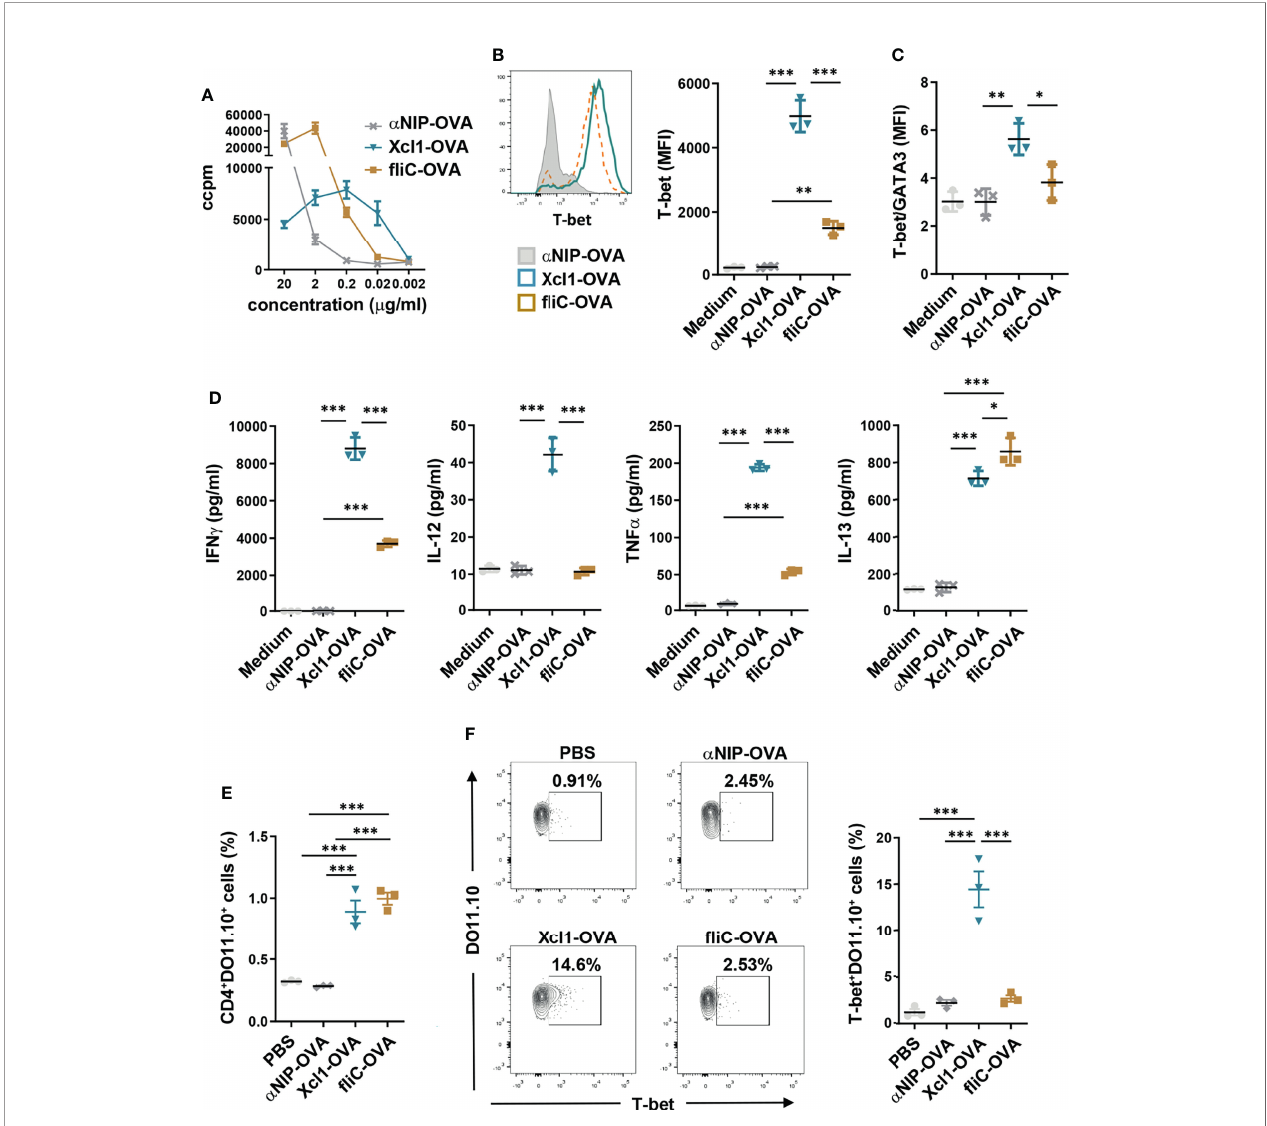
FIGURE 2 | Xcl1-OVA induces Th1 polarization of DO11.10 cells in vitro and in vivo . (A) CD4 + cells were puri fi ed from spleen of DO11.10 TCR transgenic mice and incubated with BMDCs as APC in the presence of indicated amounts of Xcl1, fl iC, or NIP-OVA protein for 72 h. Incorporation of radioactive thymidine was analyzed after 48 h. (B – D) CD4 + from DO11.10 transgenic mice were incubated with BMDC in the presence of Xcl1-, fl iC-, or NIP-OVA proteins (0.5 m g/ml) for 72 h. (B) CD4 + DO11.10 + cells were evaluated for expression of T-bet by fl ow cytometry. MFI for T-bet expression is summarized in the right graph. (C) Ratio of T-bet/GATA3 MFI for CD4 + DO11.10 + cells in mice from (B) and Supplementary Figure 3A . (D) Concentrations of IFN g , IL-12, TNF a , and IL-13 in supernatants. (E, F) 1 × 10 6 naïve DO11.10 cells were transferred to BALB/c mice that were subsequently injected i.v. with puri fi ed Xcl1-OVA, fl iC-OVA, or a NIP-OVA proteins (5 m g). Spleens were harvested 72 h later and the percentage of (E) CD4 + DO11.10 + and (F) T-bet + DO11.10 + cells determined by fl ow cytometry. Data are representative of one (A) or three (B – D) independent experiments with n = 3 samples per group. (E, F) Data from one experiment with n = 3 mice per group. Statistical analysis was performed by one-way ANOVA with Tukey ’ s multiple-comparison corrections. *p < 0.05, **p < 0.01, ***p <